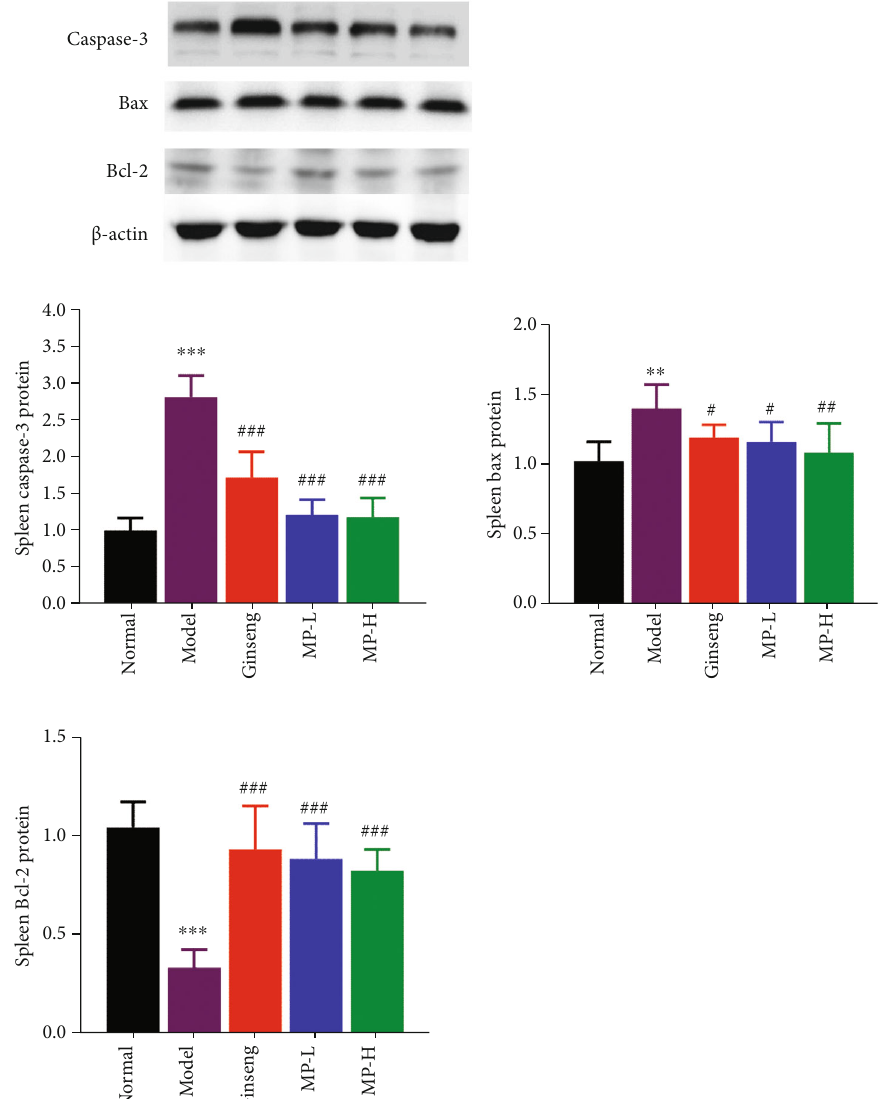
Figure 10: Protein expression of caspase-3, BAX, and the Bcl-2 in the spleen ( n = 3 ); ∗∗ p < 0 : 01 and ∗∗∗ p < 0 : 001 vs. control group; # p < 0 : 05 , ## p < 0 : 01 , and ### p < 0 : 001 vs. model